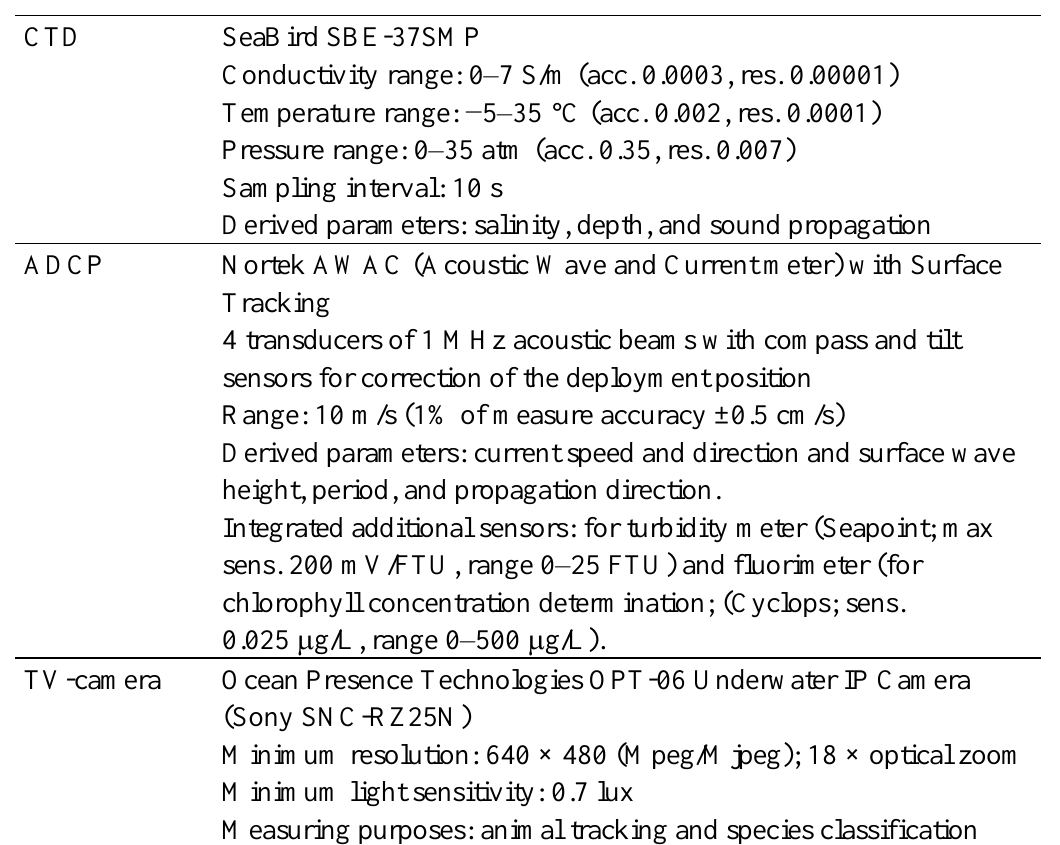
Table 1. Types and technical characteristics of sensors installed on the OBSEA seafloor cabled